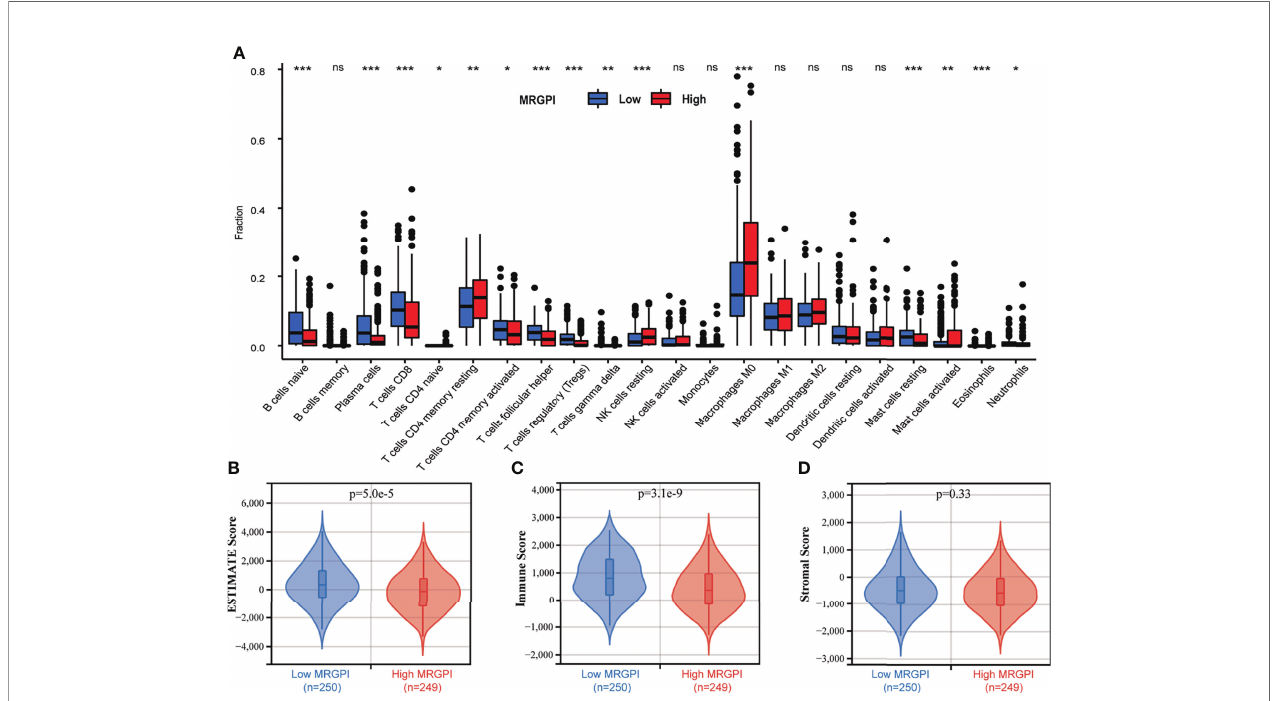
FIGURE 4 | The TME landscape of the different MRGPI subgroups. (A) The proportions of immune cells within the TME in the different MRGPI subgroups. The scattered dots represent the immune score of the two subgroups. The thick lines represent the median value. The bottom and top of the boxes are the 25th and 75th percentiles (interquartile range), respectively. Signi fi cant statistical differences between the two subgroups were assessed using the Wilcoxon test (ns, not signi fi cant; *p < 0.05; **p < 0.01; ***p < 0.001). (B) The ESTIMATE Score (tumor purity) of the two MRGPI subgroups. (C) The Immune Score of the two MRGPI subgroups. (D) The Stromal Score of the two MRGPI subgroups. TME, tumor microenvironment; MRGPI, metabolism-related gene prognostic